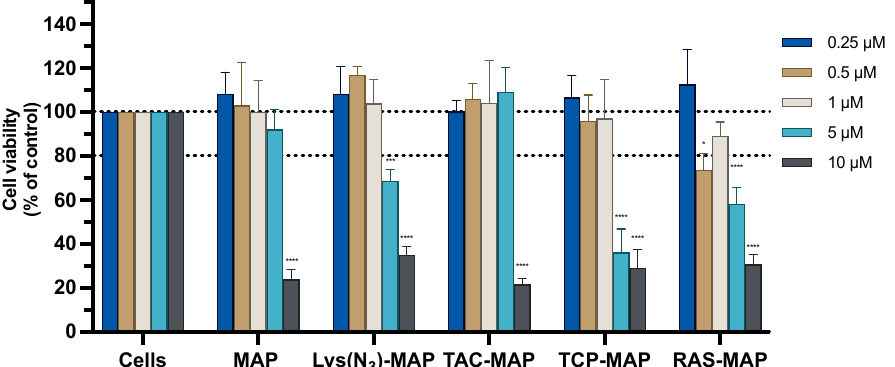
Figure 1. Relative cell viability of the Caco-2 cell line measured by the MTT reduction after 24 h incubation. Treatment with free MAP, Lys(N 3 )-MAP, TAC-MAP, TCP-MAP, and RAS-MAP (0.25–10 µ M). Results are expressed as mean ± SD (n = 3 or 6). Statistical analysis between the control groups was performed using two-way ANOVA with Tukey’s multiple comparisons test (* p < 0.05; *** p < 0.001; **** p < 0.0001).